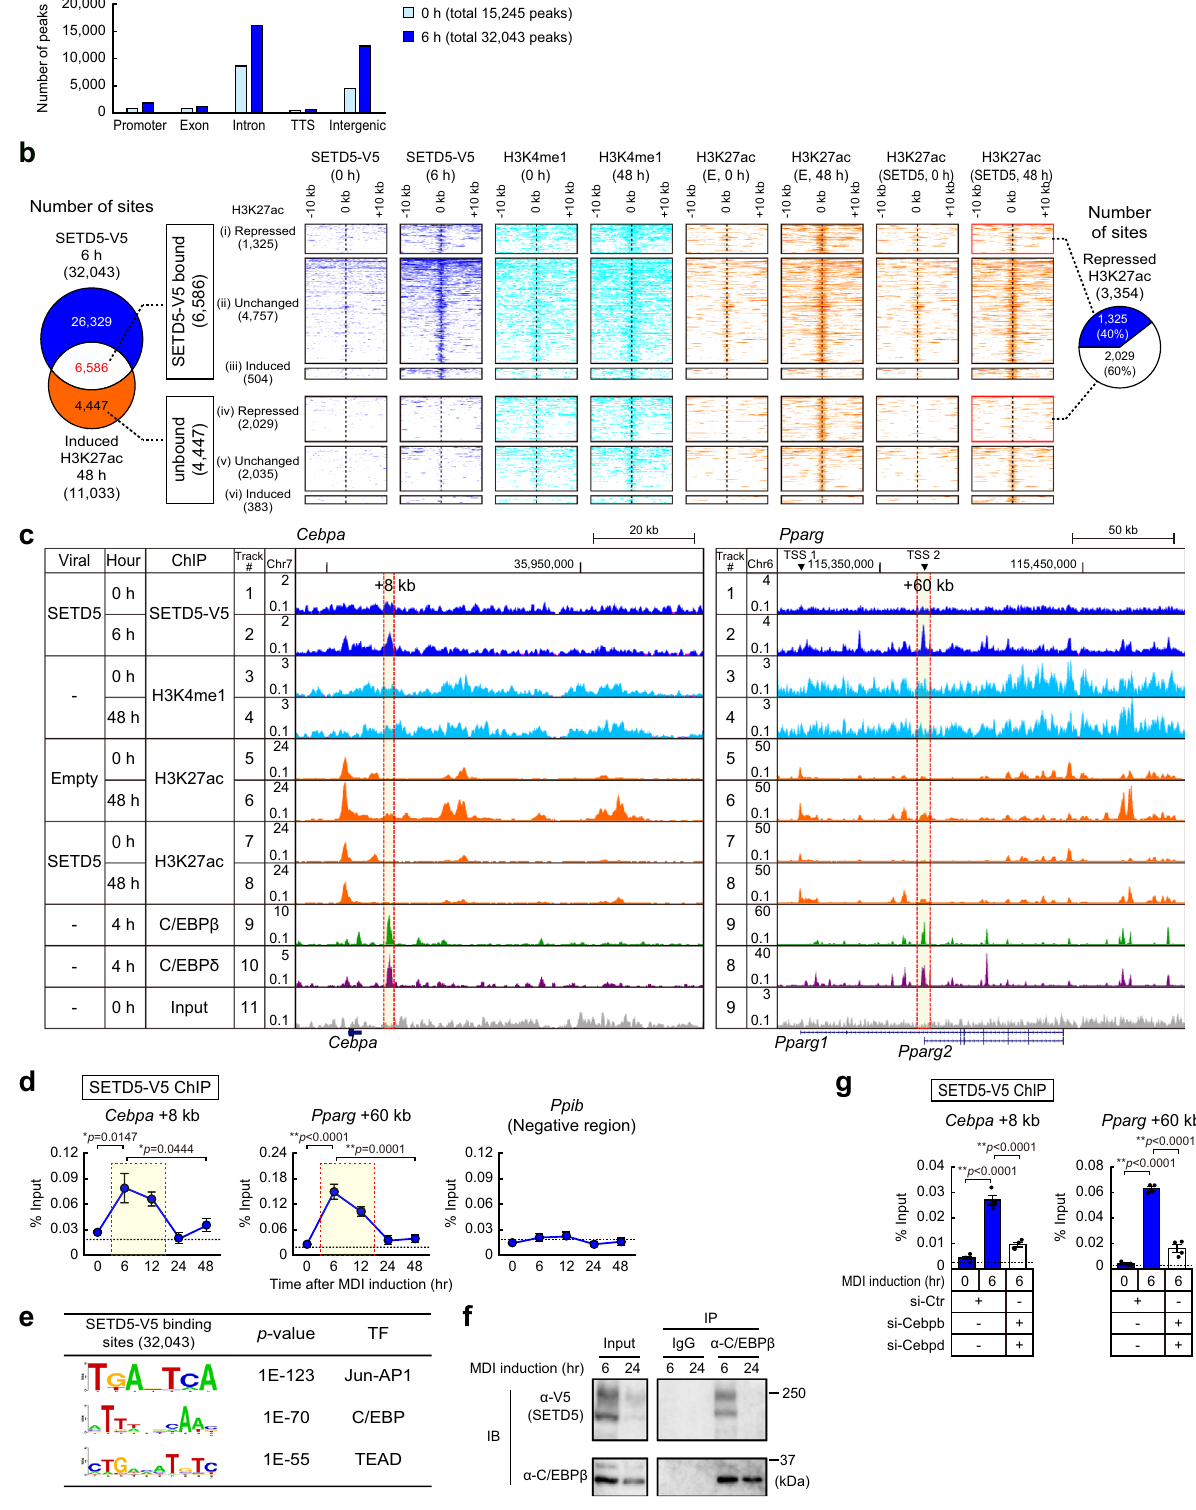
7,594 sites) were also binding sites for SETD5-V5 (Fig. 6a). A ChIP-seq genome browser snapshot shows both SETD5 and p300 HAT were recruited to primed enhancers (i.e. Cebpa + 8 kb and Pparg + 60 kb and + 158 kb) immediately after differentiation (4 – 6 h) (Fig. 6b). Unfortunately, the anti-p300 antibody used